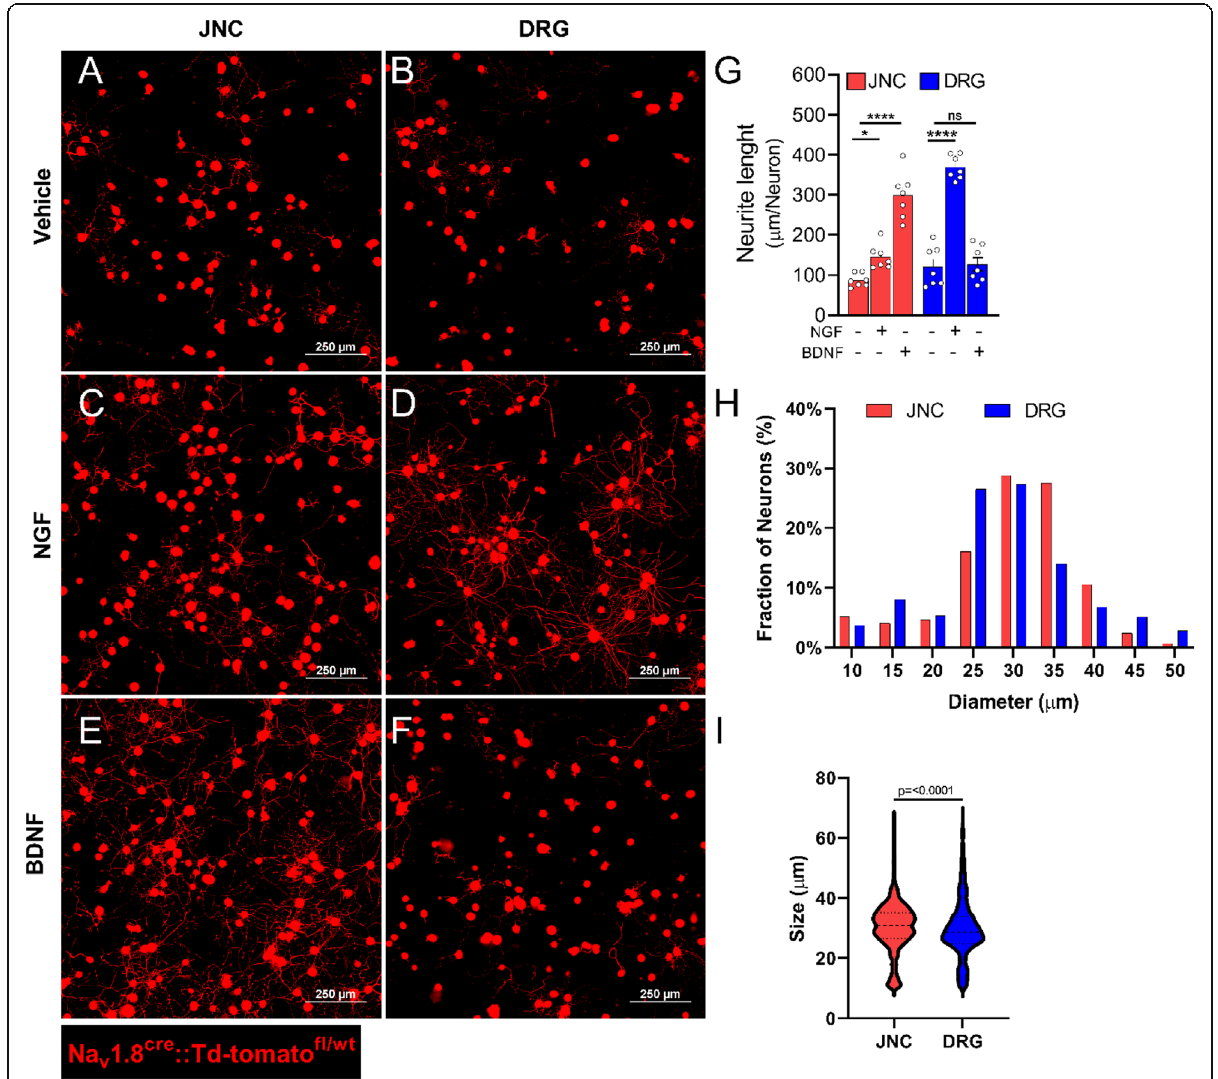
Fig. 4 Lumbar and vagal neurons are phenotypically different and respond differently to NGF and BDNF. Na V 1.8 cre ::Td-tomato fl/wt (red) mice JNC ( A, C, E ) and DRG ( B, D, F ) nociceptor neurons were harvested, and cultured (1,500 neurons/plate) for 24h in the presence of vehicle ( A - B ), Nerve Growth Factor (NGF, 50 ng/mL; C - D ), or Brain-Derived Neurotrophic Factor (BDNF, 50 ng/mL; E - F ). In comparison to vehicle, NGF increased neurite outgrowth in cultured DRG neurons, and had limited impact in JNC neurons ( G ). BDNF increased neurite outgrowth in cultured JNC neurons but had no impact in DRG neurons ( G ). In vehicle-exposed culture, JNC neurons have a larger diameter than DRG neurons ( H - I ; n>1000 neurons). Data are shown as mean ± S.E.M. N=7 dishes/group from two independent experiments ( A - I ). P-values are shown in the figure and determined by one-way ANOVA post hoc Dunnett ( G ) or Mann-Whitney Test ( I ). Scale = 250 μ m ( A - F ). NaV1.8 + nociceptors are labeled in red ( A - F